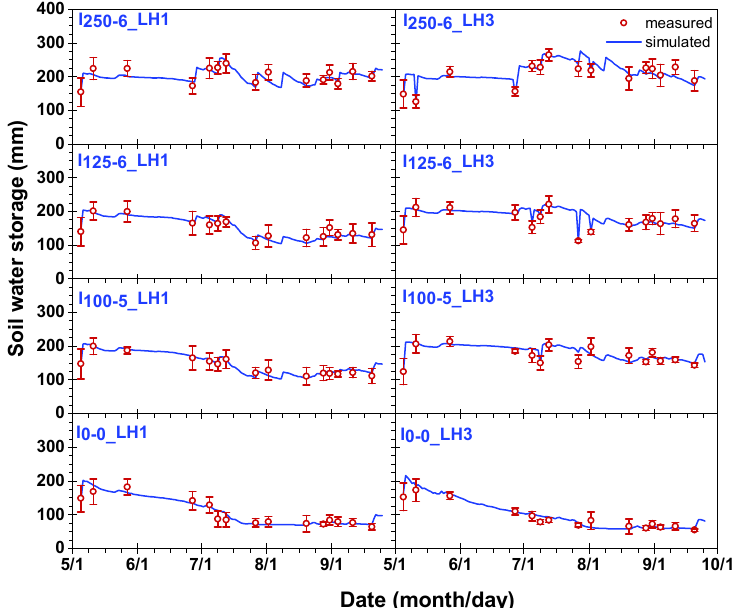
Figure 1. Comparison of the measured and simulated soil water storage in 0–100 cm soil profile under different irrigation schedules for LH1 and LH3 in 2020.